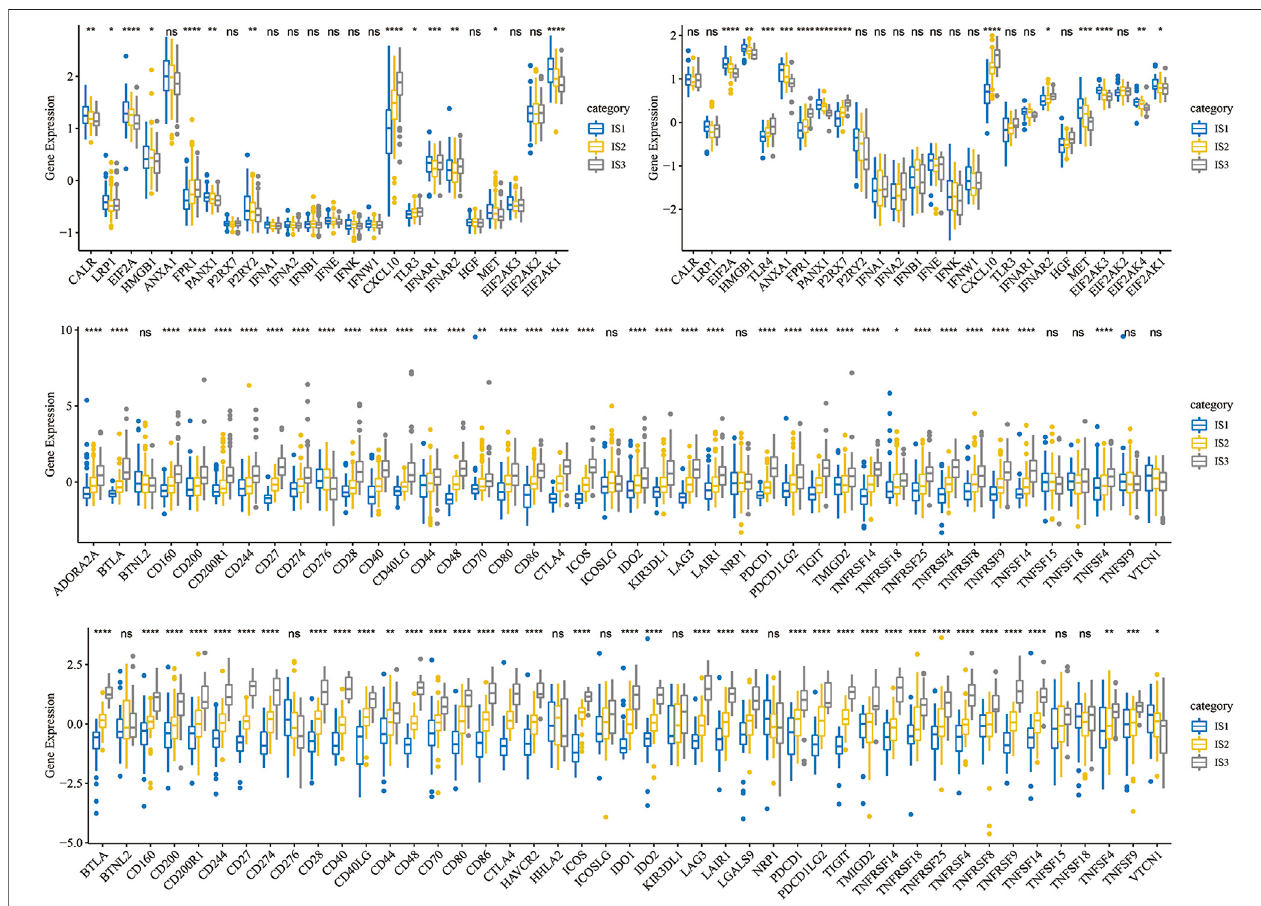
FIGURE 3 | (A) Differential expression distribution of classic markers induced by chemotherapy in the METABRIC-TNBC cohort. (B) Differential expression distributionofclassicmarkersinducedbychemotherapyintheGSE58812cohort. (C) DifferentialexpressiondistributionofimmunecheckpointgenesintheMETABRIC- TNBCcohort. (D) Differentialexpression distributionofimmunecheckpoint genesintheGSE58812 cohort. ANOVA tested signi fi cantdifferences.*represents p < 0.05, ** represents p < 0.01, *** represents p < 0.001, and **** represents p < 0.0001.